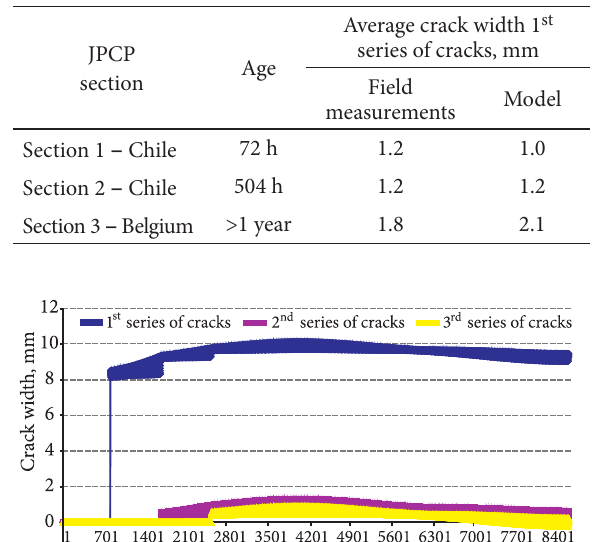
Table 3. Comparison between the model and field measurement results